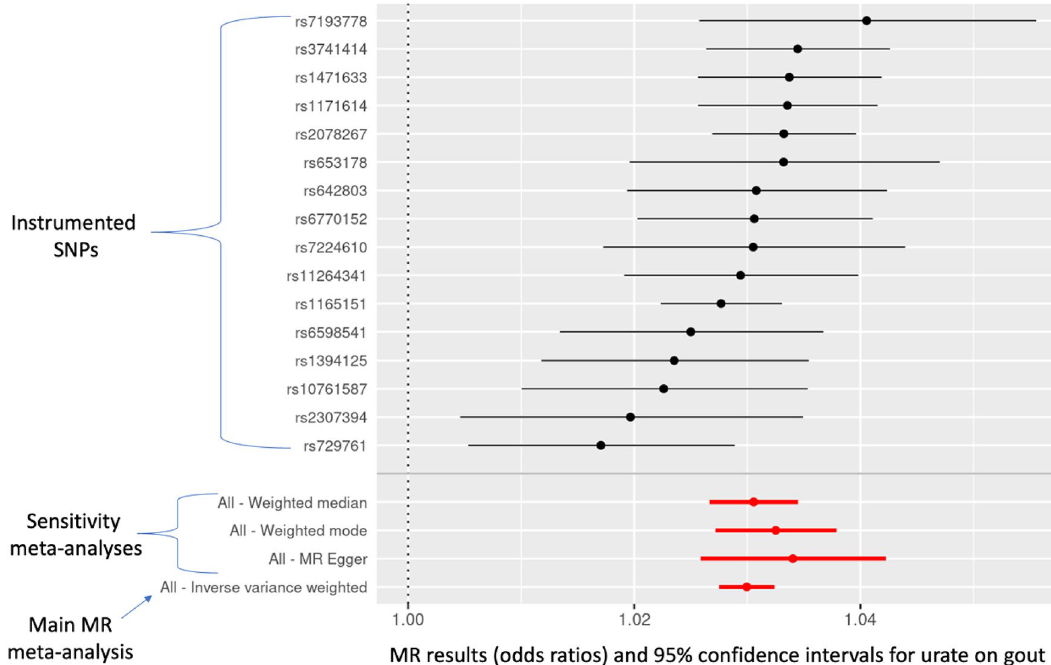
inverse-variance weighted (IVW) result is the main MR